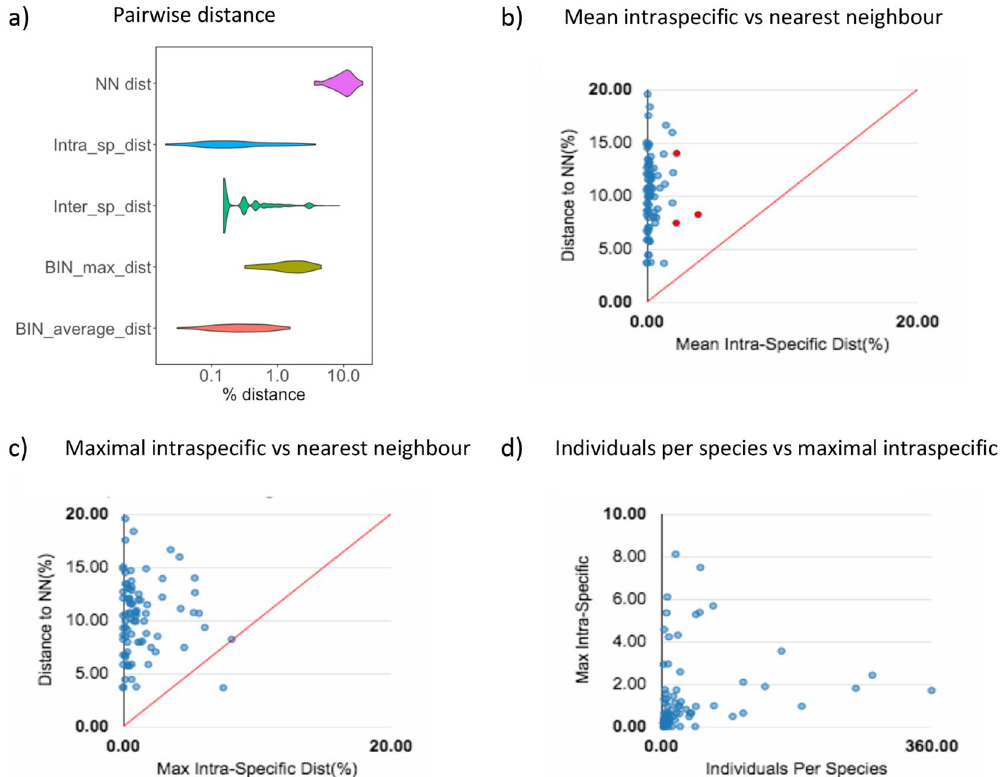
Figure 3. Kimura 2 Parameter distances for species with a number of records n ≥ 3. ( a ) Violin plot representing Nearest-neighbor (NN), Mean Intra and Inter specific genetic distances and BIN maximal and average distances; ( b ) Mean intra-specific distances vs the minimum inter-specific distances, species with intra-specific distances over 2% are depicted in red; ( c ) Maximal intra-specific distances vs . the minimum inter-specific distances; ( d ) Number of individuals in each species against their max intra-specific